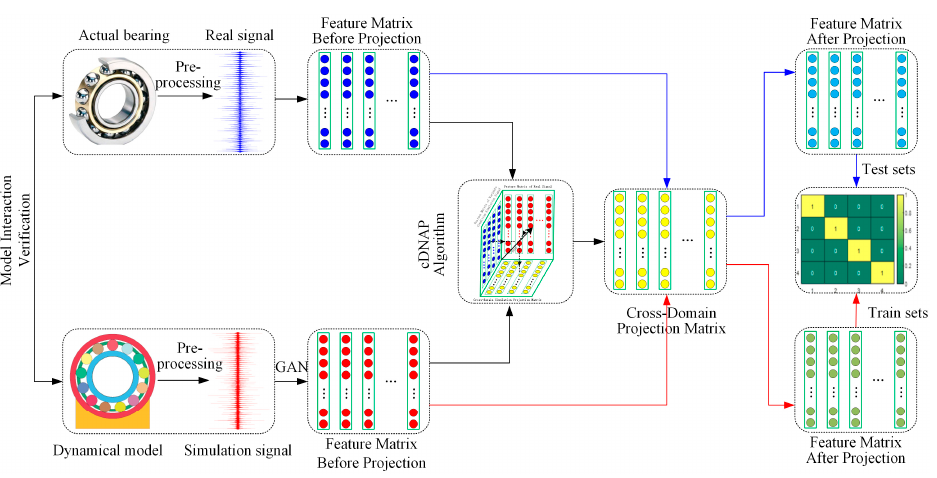
Figure 2. Flow chart of fault diagnosis based on